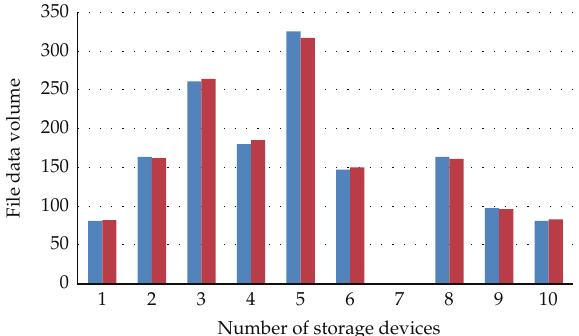
Figure 7: Comparison between the actual and theoretical allocation after deleting no. 7